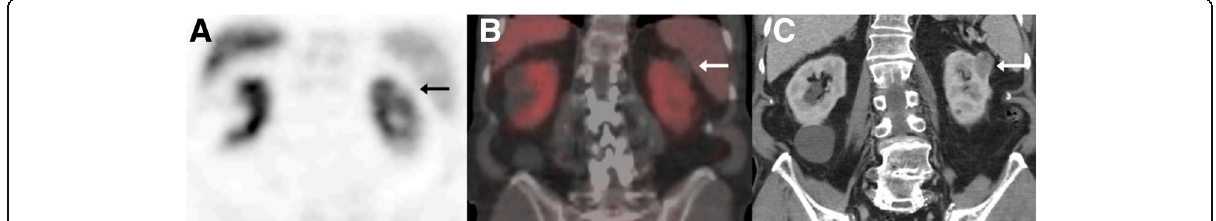
Fig. 2 Scintigraphic coronal view demonstrates the absence of radioisotope ( arrow ) in the upper part of left kidney ( a ). Preoperative CT study, venous phase in coronal view ( c ) of the same patient for anatomical correlation of the renal lesion. b Fused coronal SPECT/CT image with a solid